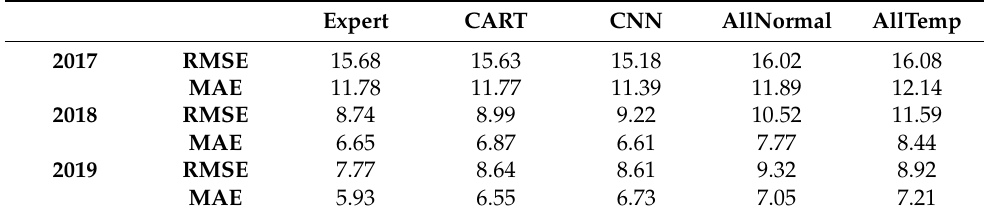
Table 3. PM 2.5 forecast performance of various model strategies with short-term training in six days.